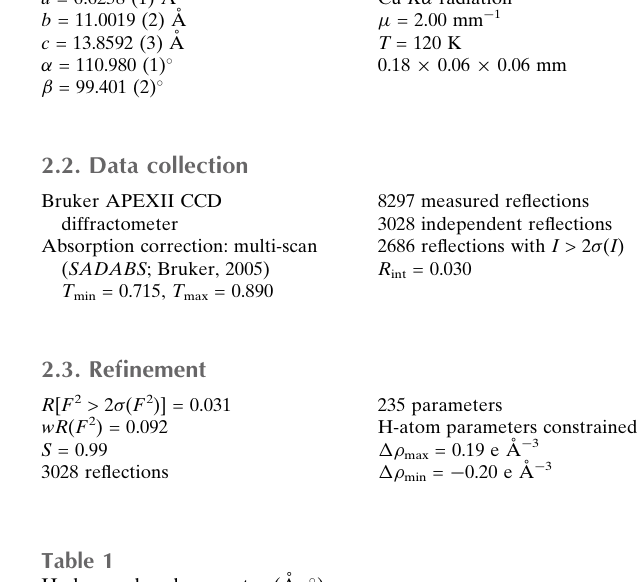
Hydrogen-bond geometry (A˚ , (cid:2)